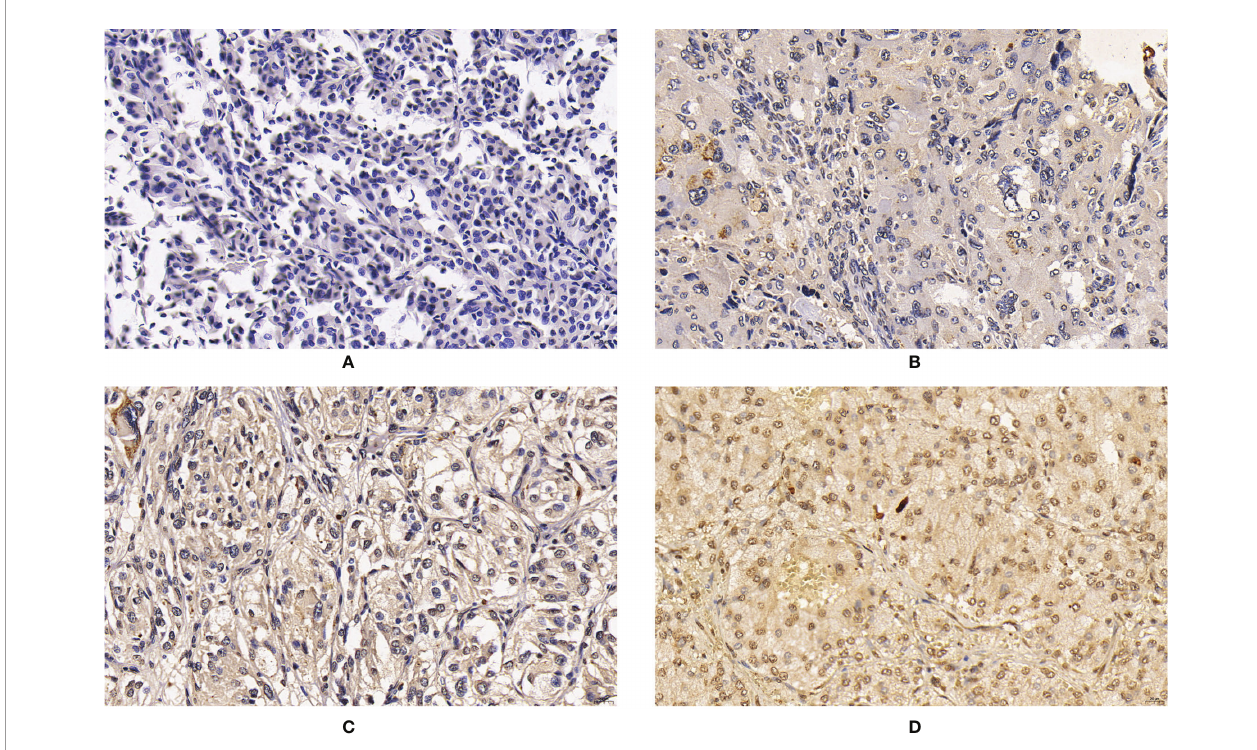
FIGURE 2 | Expression of CNTN4 in PPGLs. (A) Negative immunostaining of CNTN4 in PPGLs. (B) Weakly positive immunostaining of CNTN4 in PPGLs. (C) Intermediately positive immunostaining of CNTN4 in PPGLs. (D) Strongly positive immunostaining of CNTN4 in